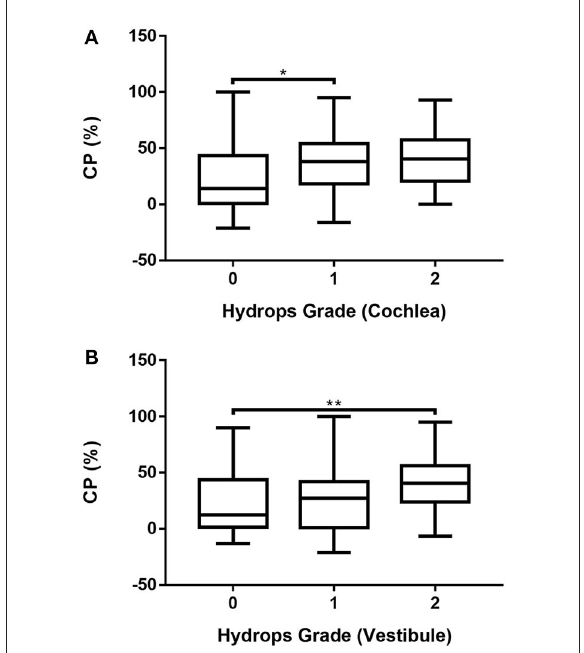
FIGURE5 Associations of cochlear (A) and vestibular (B) hydrops grades 0, 1, and 2 with CP in 107 patients with unilateral MD determined by one-way ANOVA with Scheffé’s post-hoc multiple comparison test. * p < 0.05; ** p <